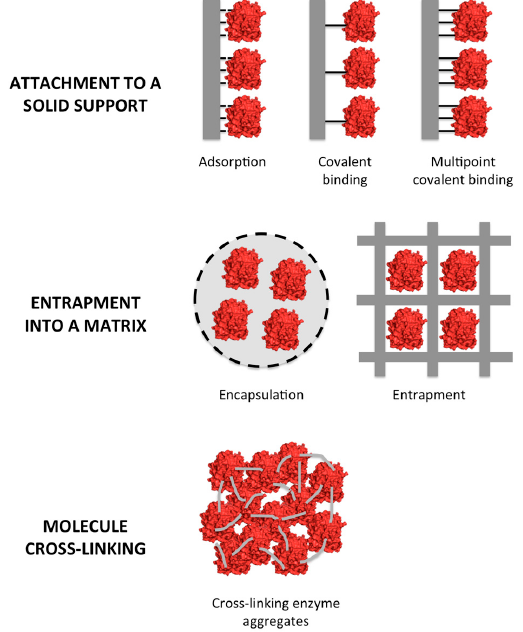
Figure 1. Types of immobilization.